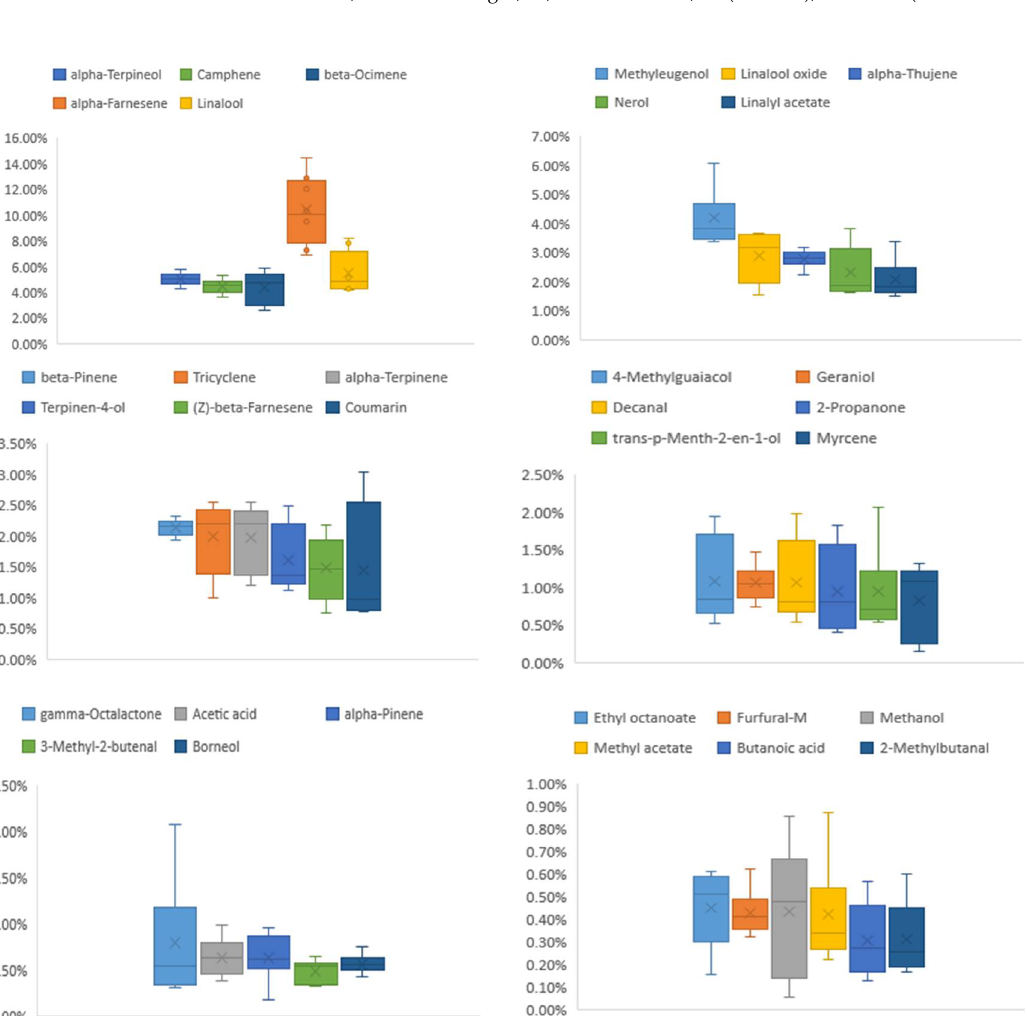
Figure 1. The three−dimensional spectrum of volatile compounds in Qu Aurantii Fructus.